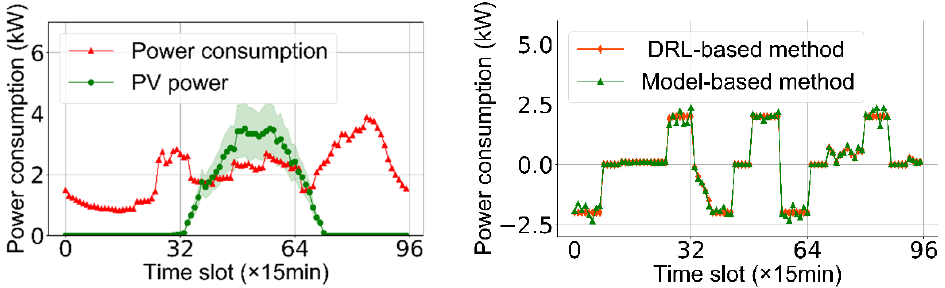
Figure 15. Comparison of consumption power between MAPPDG and the model-based method in strong light.